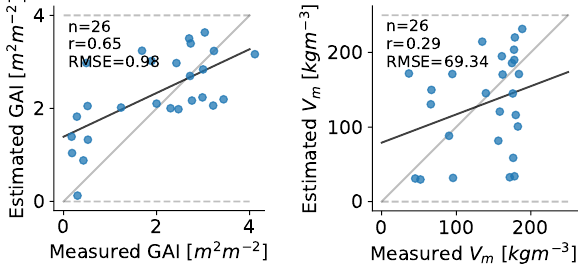
Figure 14. Results from the LOOCV for the simultaneous retrieval of maize GAI and volumetric surface soil moisture, V m , using a RFR with C-band data in VH and VV